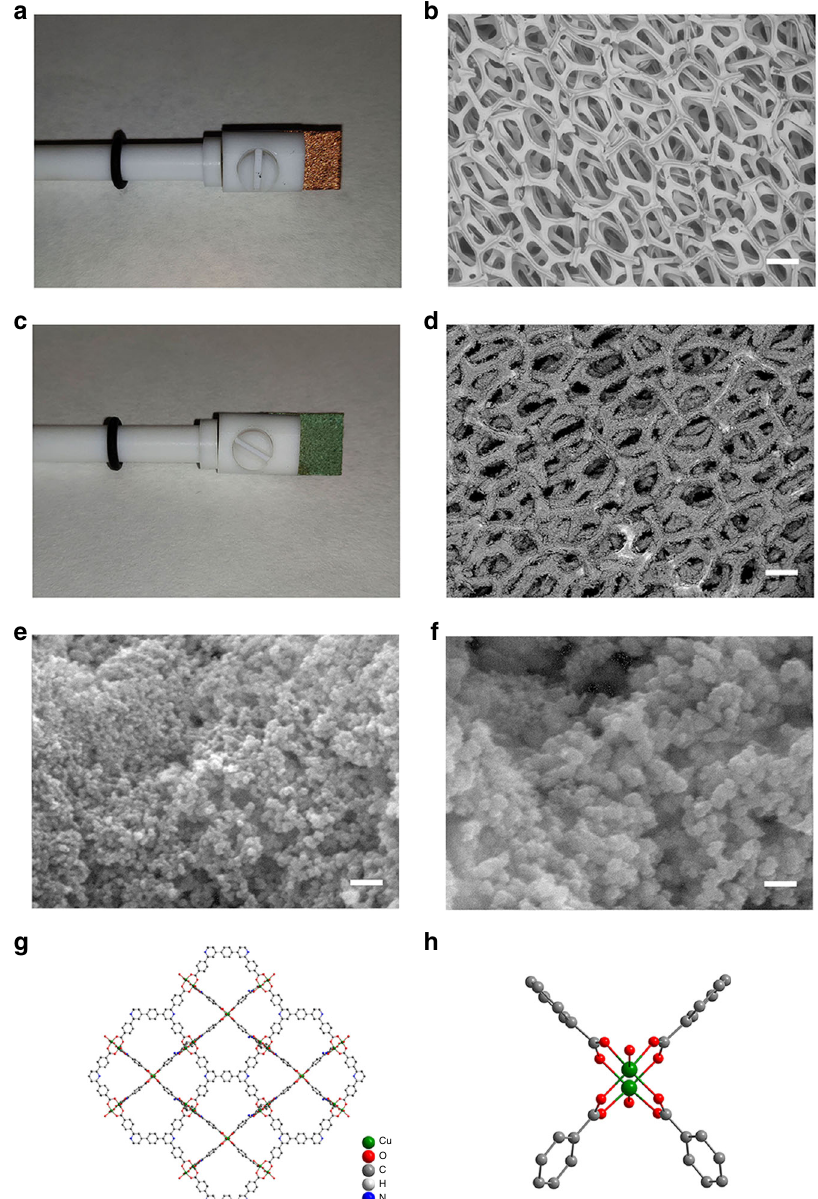
Fig. 1 Images and morphology. a , b Photograph ( a ) and SEM image ( b ) of a fresh Cu-foam electrode (0.5 × 1.0 cm 2 ). c Photograph of the as-prepared electrode Cu 2 (L)-e/Cu (0.5 × 1.0 cm 2 ). d – f SEM images of the as-prepared electrode Cu 2 (L)-e/Cu. g – h Views of the crystal structure of [Cu 2 (L)] (CCDC 1531622) 31 . Hydrogen atoms are omitted for clarity. The scale bars of b , d – f are 300 µ m, 300 µ m, 300 nm and 100 nm,